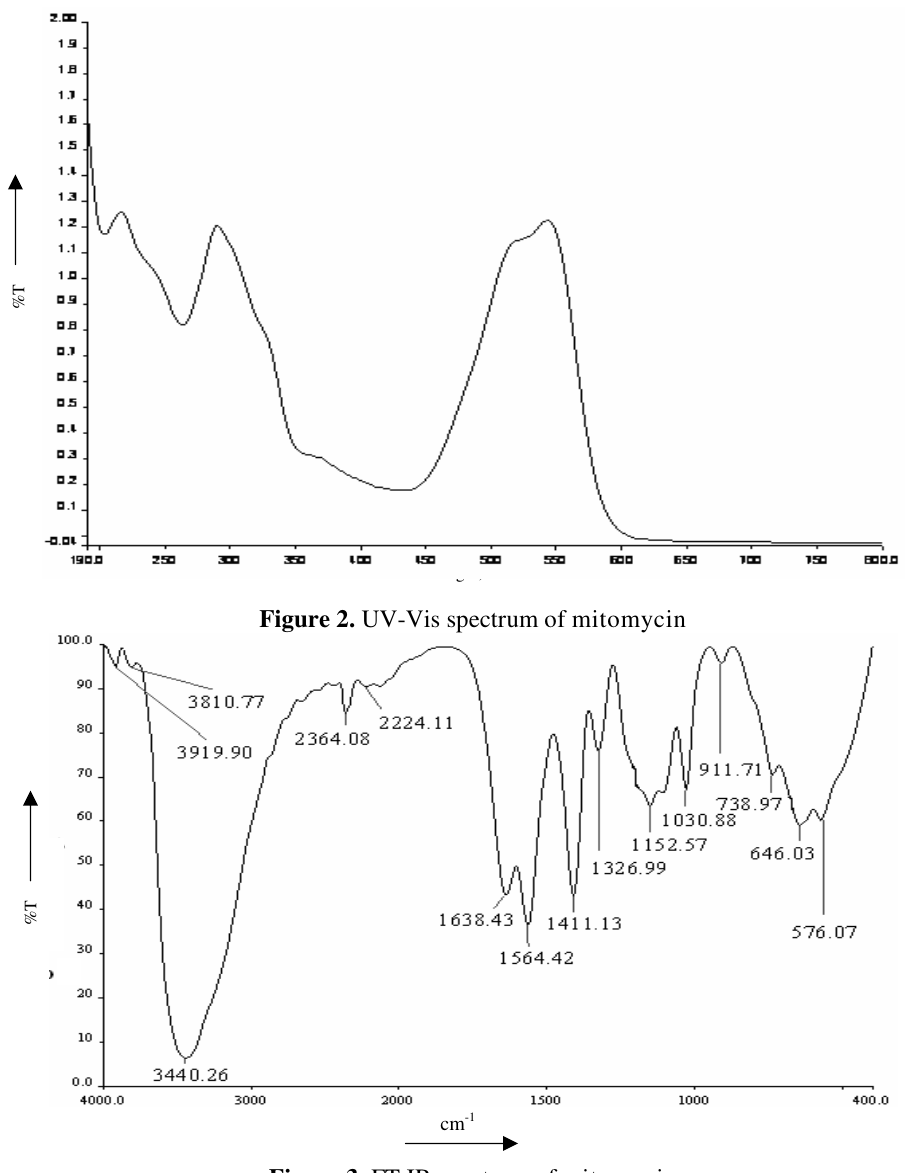
Figure 3. FT IR spectrum of